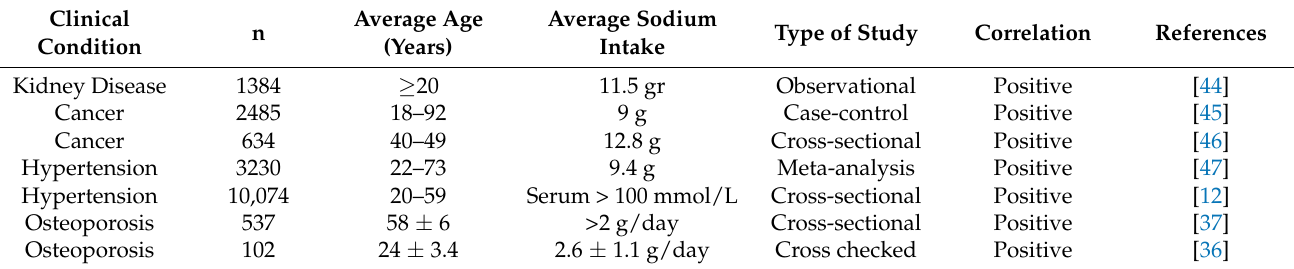
Table 1. Relationship of clinical conditions with high sodium intake.